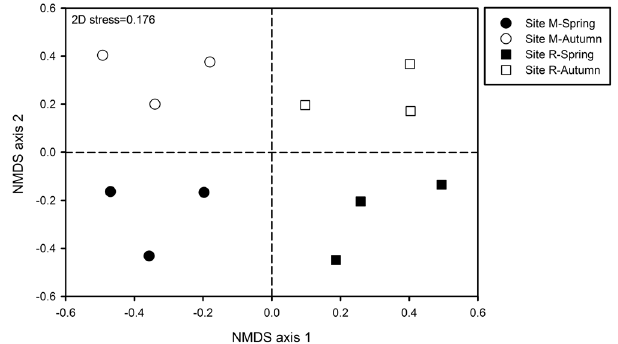
Figure 4. Nonmetric multidimensional scaling (NMDS) ordination of microbial functional gene community structure based on Geochip 5.0 hybridization signal intensities (using Bray-Curtis similarities) found at the deciduous forest site M (545–570 m asl) and the coniferous forest site R (1,724–1,737 m) in spring and